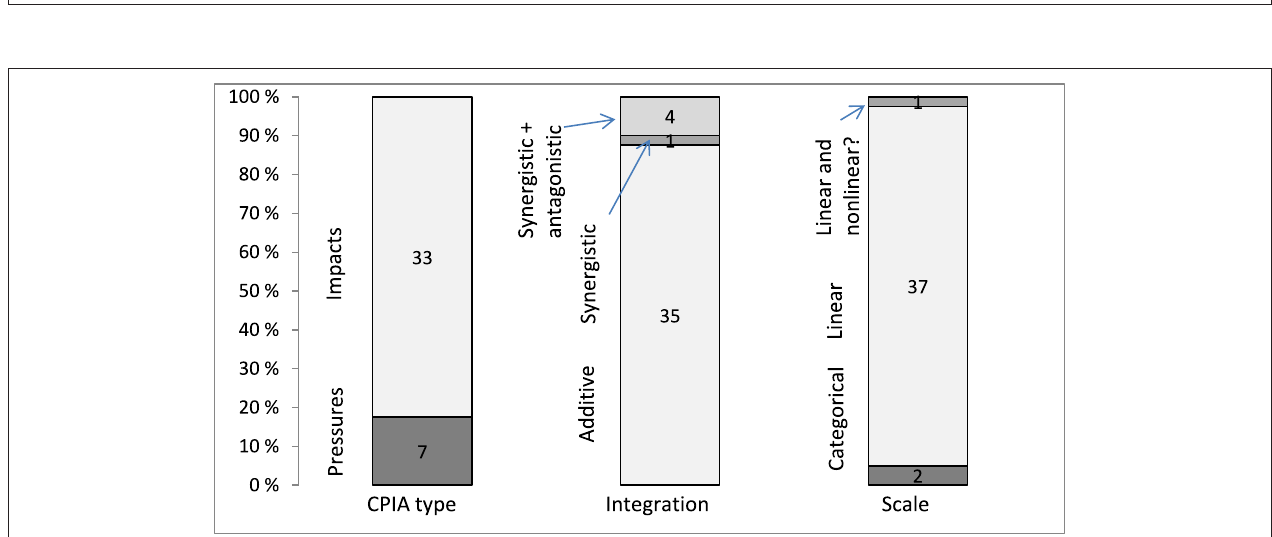
FIGURE 2 | Summary information of the 40 cumulative pressure and impact assessments (CPIA) included in the review. The CPIA type is divided into pressure and impact assessments. The integration was additive, synergistic or synergistic, and antagonistic. The scale of the pressure-impact relationship is divided into categorical, linear and linear and non-linear (with some uncertainty of this indicated by ?-mark).